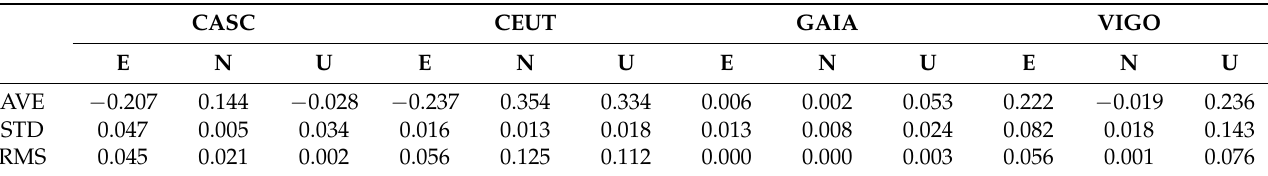
Table 10. Statistics results from the Test